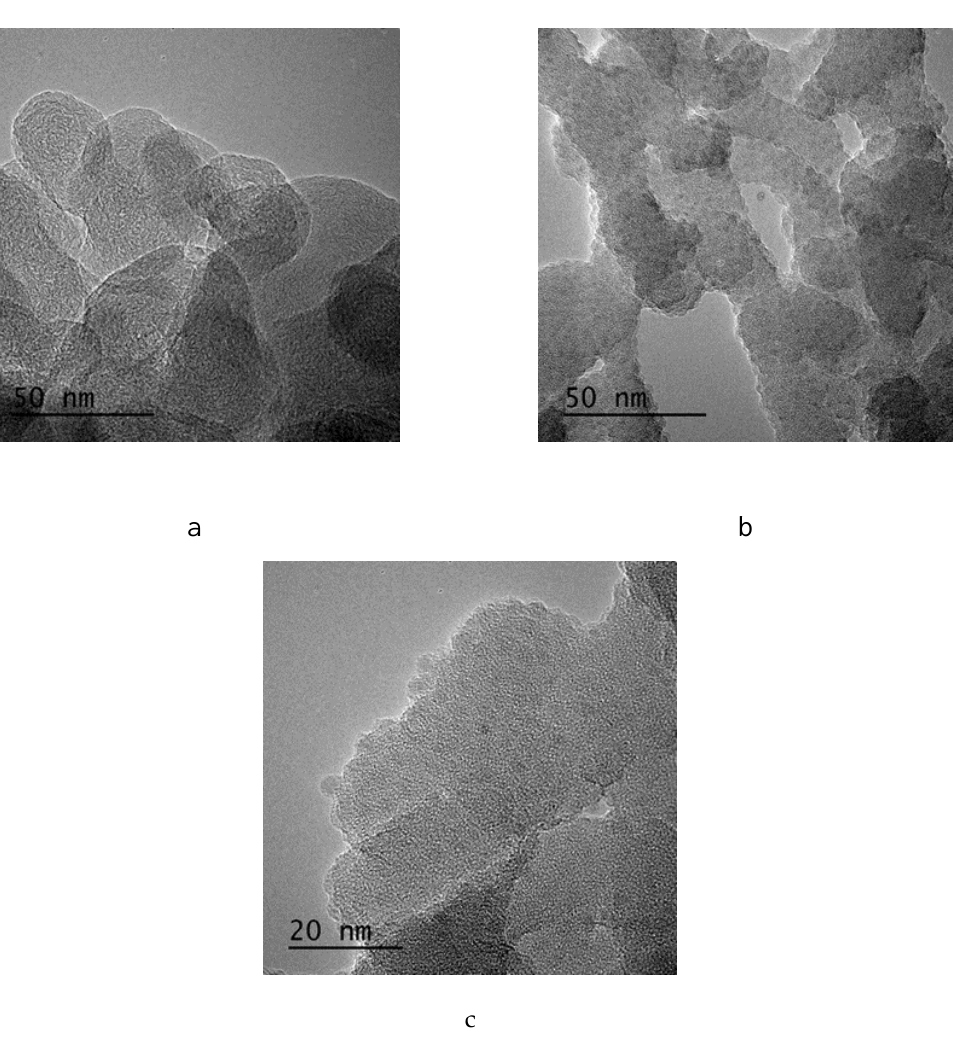
Figure 5. TEM images of ( a ) neat GNP, ( b ) and ( c ) its hybrid of Si:GNP = 1:10.